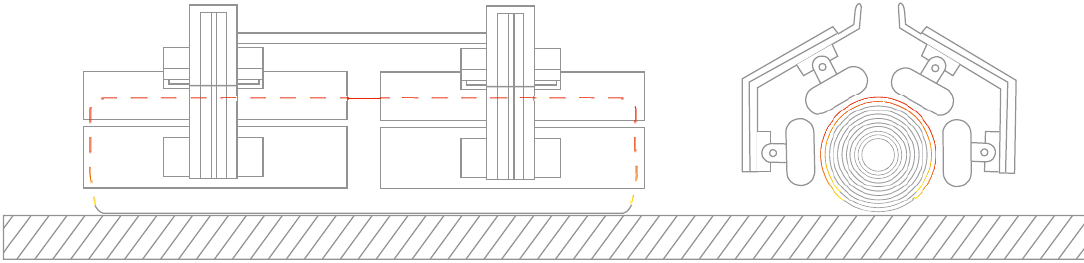
Figure 5. Lateral and front views of the heating structure with the eight infrared heaters that warm the asphalt roll.